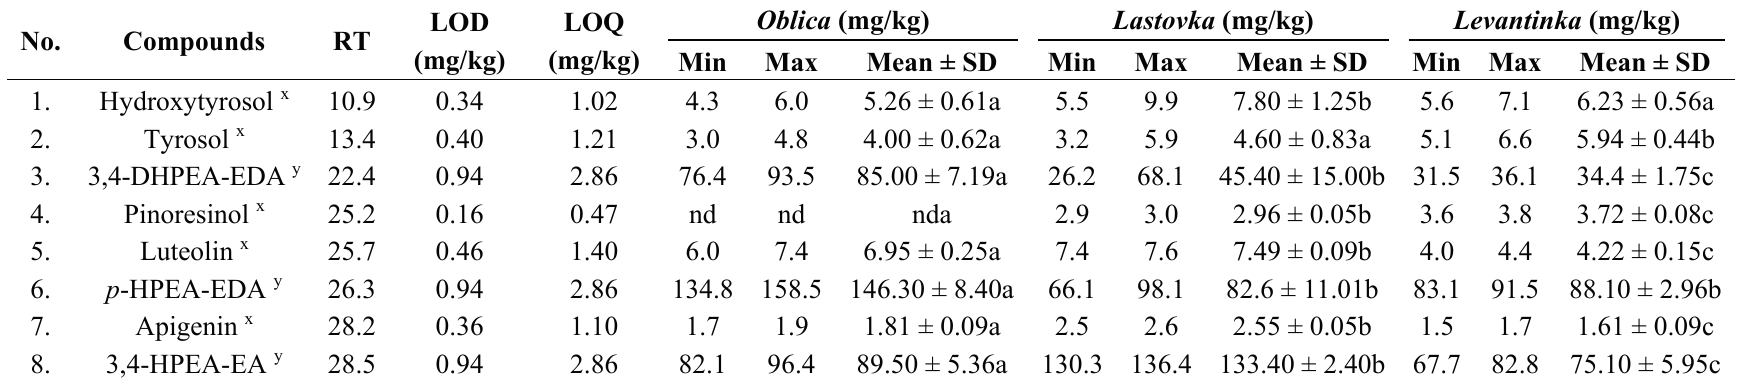
Table 5. Targeted phenolics from Oblica , Lastovka and Levantinka VOOs hydrophilic fraction determined by